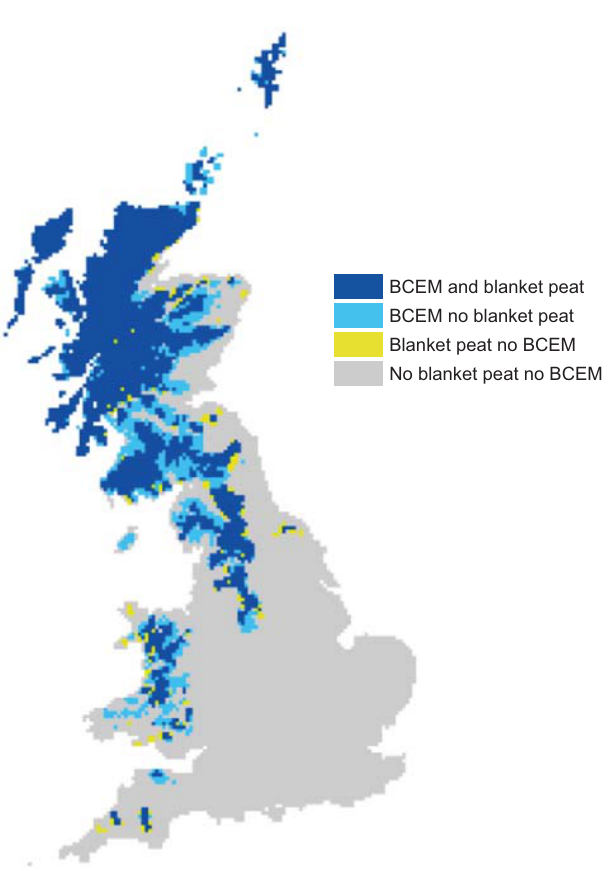
Figure 1. The area of blanket peat predicted by the bioclimatic en- velope model (BCEM) PeatStash using a baseline climate period (UKCIP02: 1961-90) overlain on the mapped 5km gridded data of observed blanket peat presence ( © Crown Copyright/database right 2009. An Ordnance Survey/EDINA supplied service. Met Of- fice/UKCIP gridded climate data. UKCIP02 © Crown Copyright